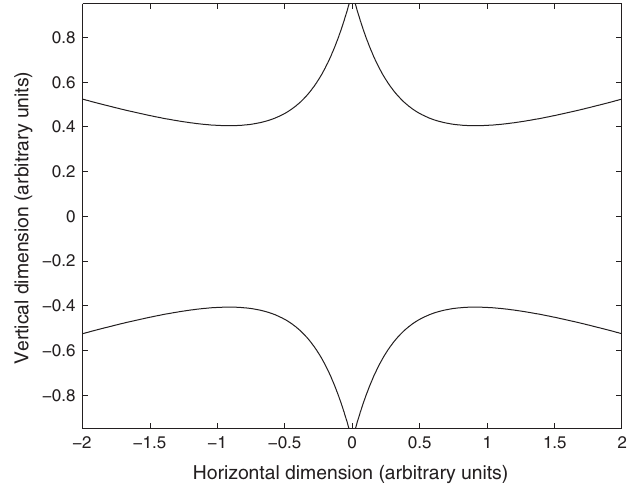
FIG. 6. Nonlinear lens magnet pole profile (arbitrary